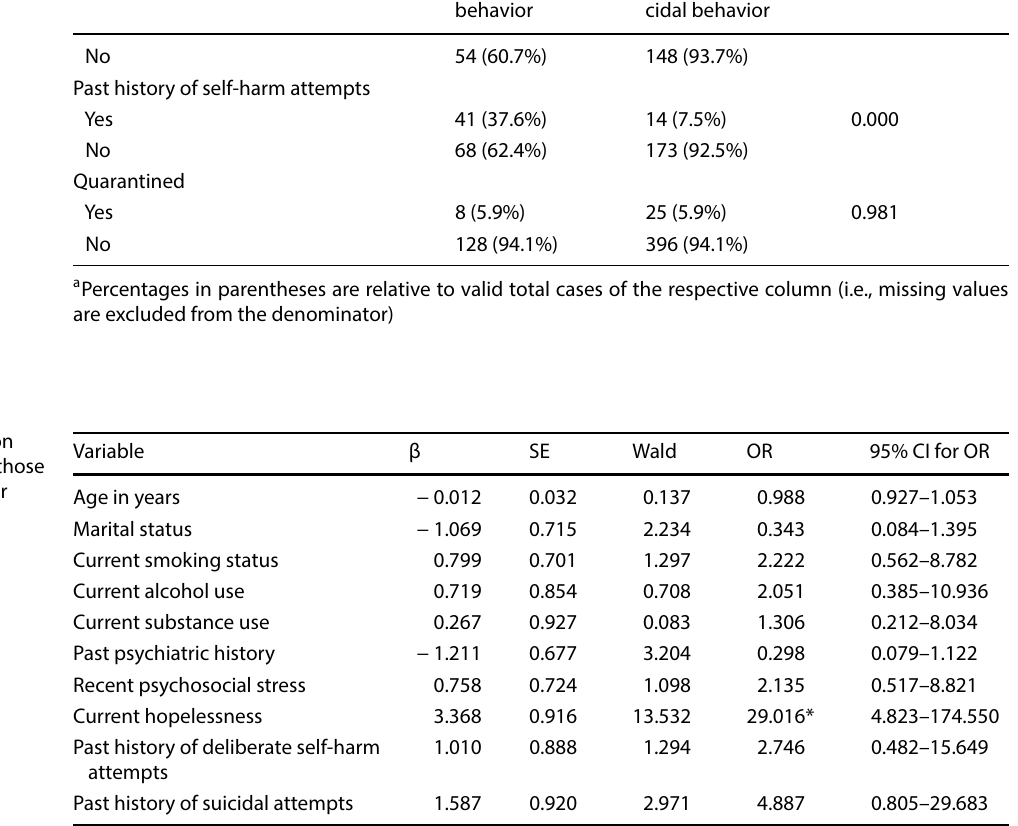
Variables past history of suicidal thoughts, and deliberate self-harm thoughts were removed due to mul- ticollinearity. Cox and Snell R 2 = 0.450, Nagelkerke R 2 = 0.621, Hosmer and Lemeshow goodness-of-fit χ 2 = 3.942, p =